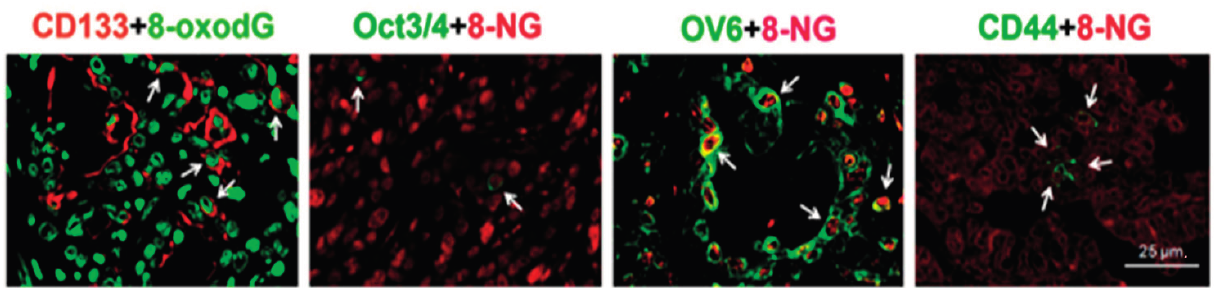
Figure 4. Double-immunofluorescence staining of stem/progenitor cell markers (CD133, Oct3/4, OV6 and CD44) and DNA lesions (8-oxodG and 8-nitroguanine (8-NG)) in cholangiocarcinoma tissues. White arrows indicate co-localization of DNA damage marker and stemness marker in cancer cells. Original magnification is ×400; Scale bar = 25 μ